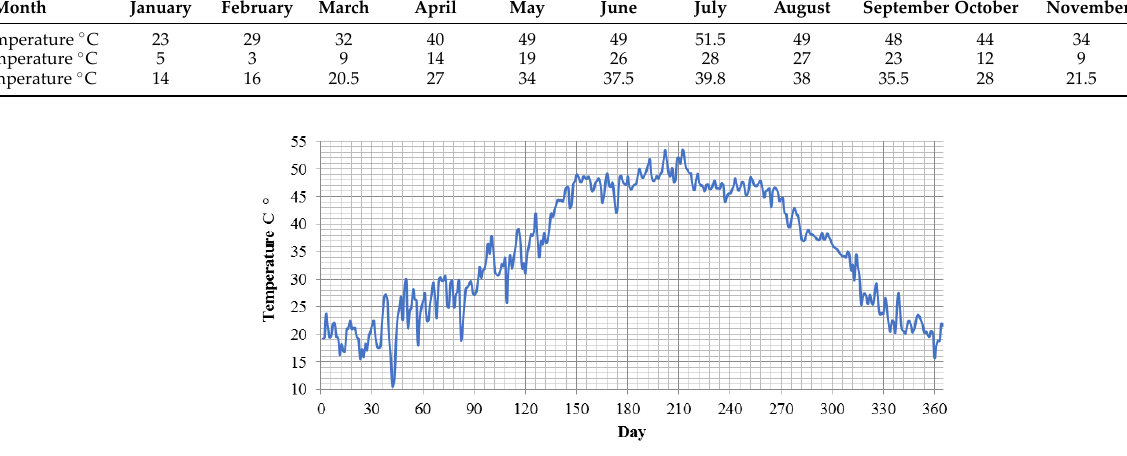
Table 2. Minimum and maximum air temperature in Celsius [80].